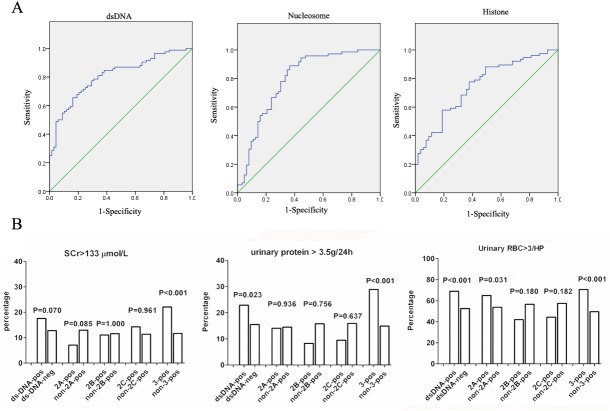
Three-pos by Euroline ANA profile (IgG) was a marker for severe nephropathy in LN patients.
(A) Power of anti-dsDNA, -nucleosome and–histone Abs to differentiate active LN from inactive LN accessed by ROC curve. (B) Three-pos was the best marker for severe nephropathy. The relevant laboratory parameters on nephropathy includes increased Scr (≥ 133μmol/L), urinary protein (≥ 3.5g/24h) and urinary RBC (≥ 3/HP). 2A, 2B and 2C respectively indicated varied 2-pos by Euroline ANA profile (IgG) in LN patients; 2A: anti-dsDNA and -nucleosome; 2B: anti-dsDNA and -histone; 2C: anti-nucleosome and -histone.